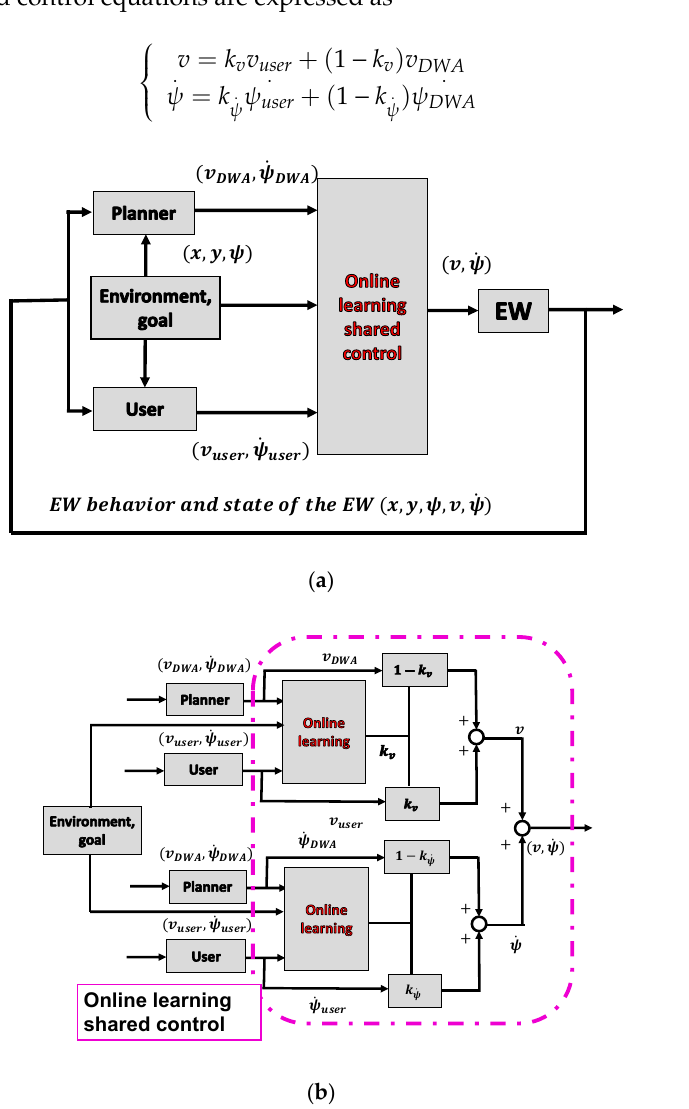
Figure 5. Construction of the shared control system: ( a ) framework of the shared control system and ( b ) online learning part.